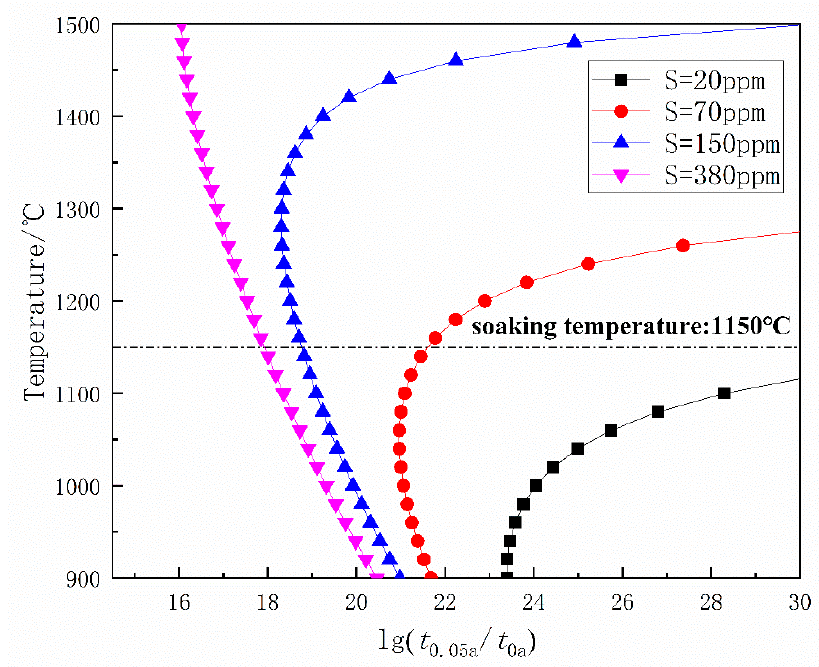
Table 5. Main kinetic parameters of MnS formation in steels [16]. kinetic Parameters